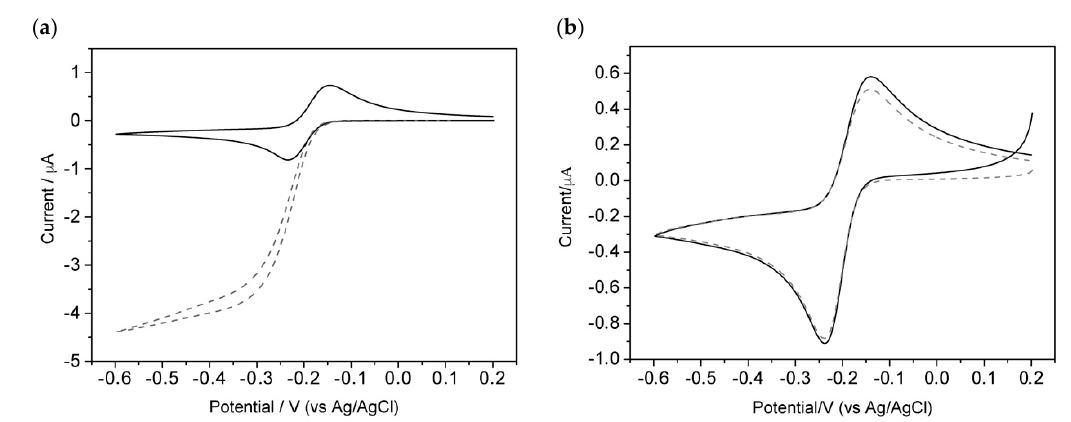
Figure 4. Cyclic voltammograms of ( a ) the immunosensor recorded in the absence (dashed line) and presence of 1.2 mM H 2 O 2 and ( b ) the immunosensor without the incubation step with gliadin (negative control) recorded in the absence (dashed line) and presence of 1.2 mM H 2 O 2 . Scan rate, 50 mV s − 1 ; supporting electrolyte, 0.1 mM MB in 0.01 M PBS; and pH 7.2.